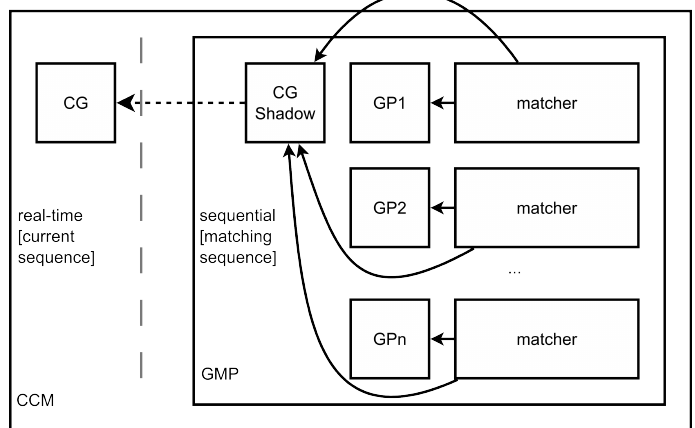
Figure 5. Architecture of the Continuous Context Matching Platform (CCM) for a